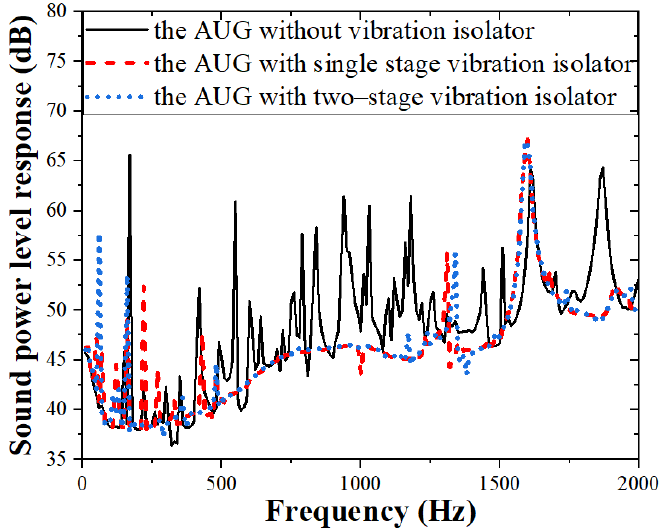
Figure 16. The sound power level of the AUG in water.